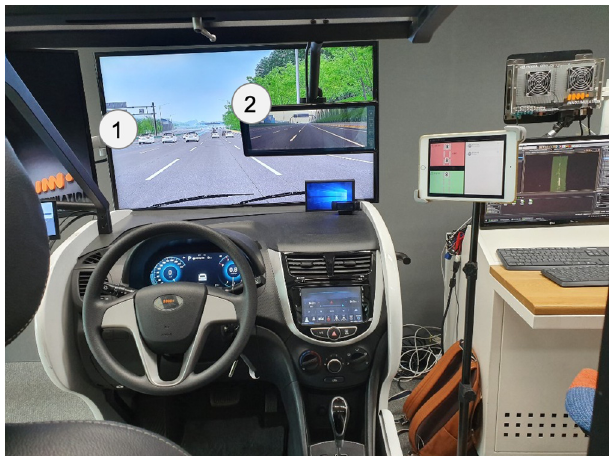
Figure 9. Descriptions of how the participant responds to the emergency braking situation (Source: Own creation): ( 1 ) the participants can use the frontal windshield since the telematics system does not support the function that informs frontal situation information and ( 2 ) the participant can recognize the rear situation through the rear camera.